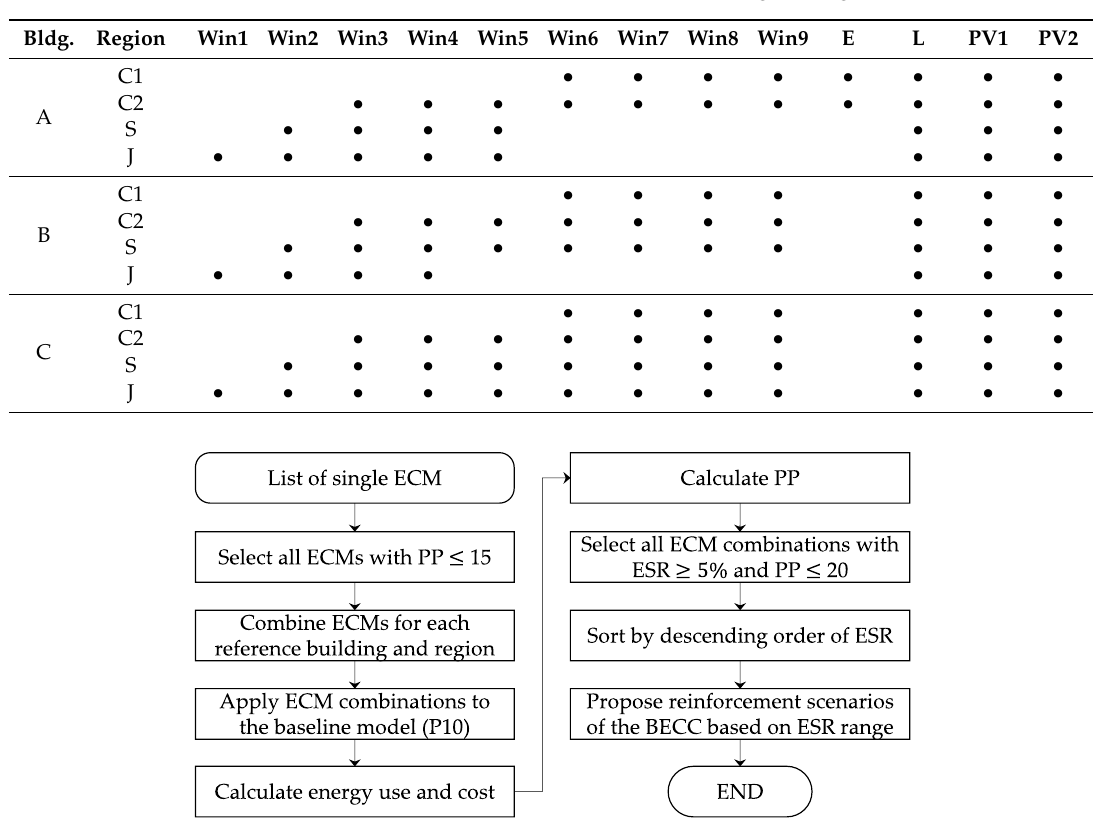
Figure 8. The process for analyzing energy saving and economic efficiency for ECM combinations.